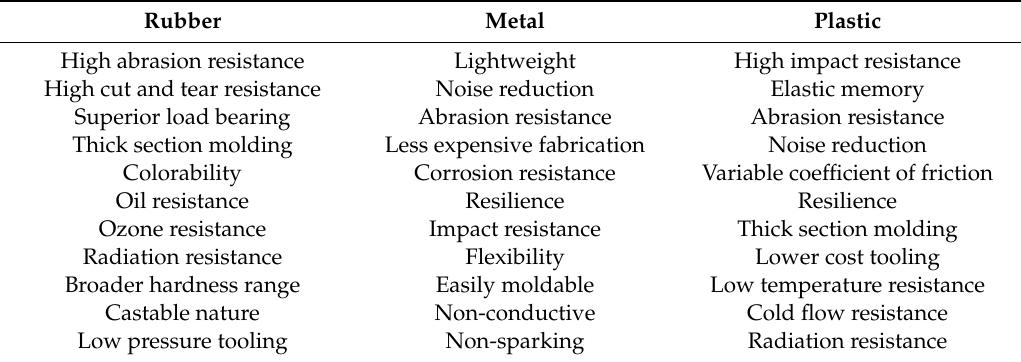
Table 1. Advantages of polyurethanes against chosen